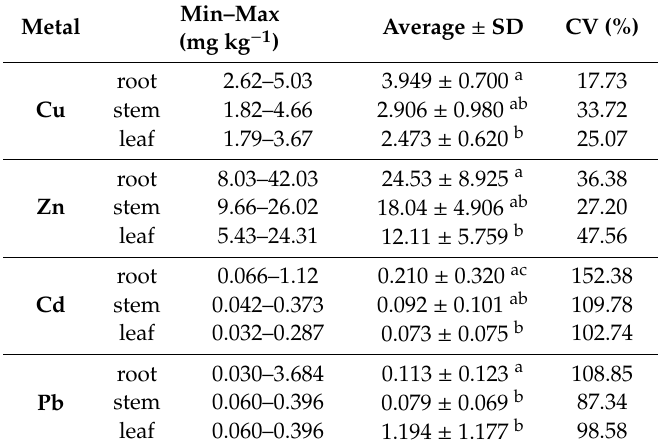
Table 1. The concentration of heavy metals (mg kg − 1 ) in the individual parts (root, stem, leaf) of Trapa natans